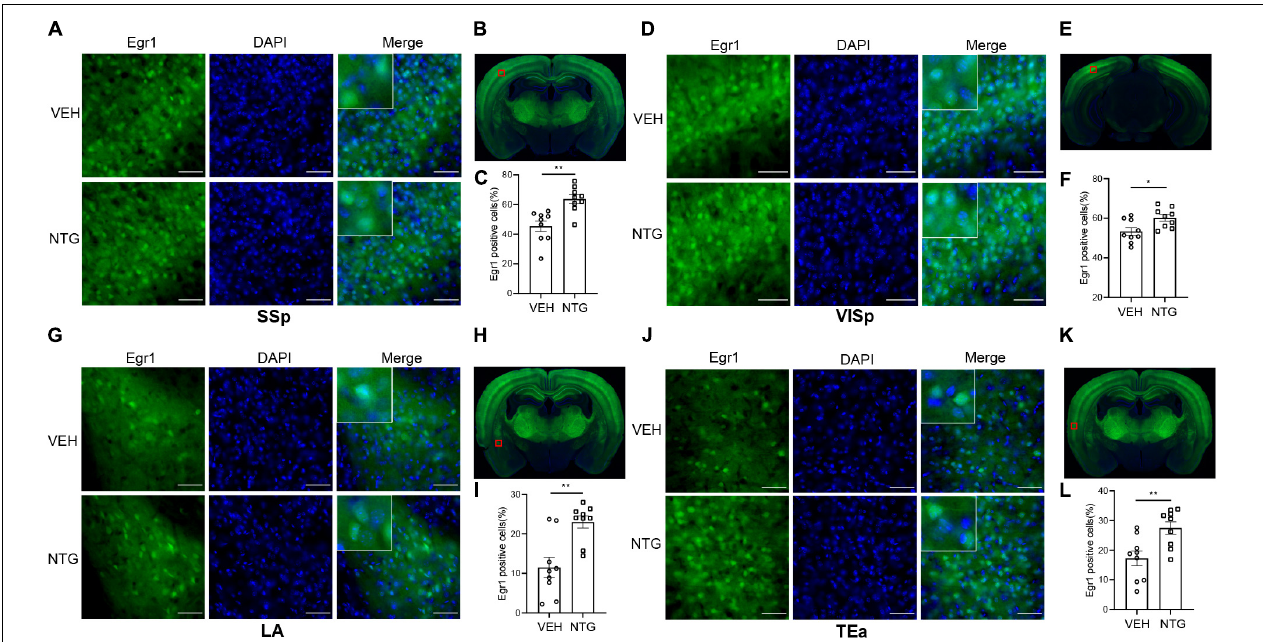
FIGURE 2 | Egr1 expression in SSp, VISp, LA and TEa. More Egr1 positive cells were found in SSp (A,C) , VISp (D,F) . LA (G,I) and TEa (J,L) of CM models compared with the control group. (B,E,H,K) Schematic representations of the analyzed areas. Student’s t -test. n = 3/group. * p < 0.05, ** p < 0.01 compared with vehicle. Scale bars = 50 µ m. Egr1, early growth response protein 1; SSp, primary somatosensory cortex; VISp, primary visual area; LA, lateral amygdala nucleus; TEa, temporal association areas.